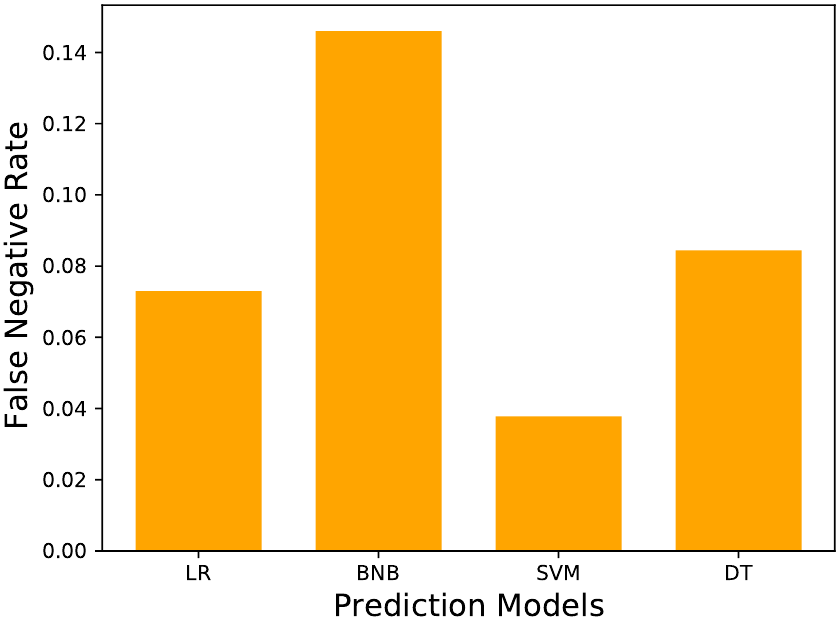
Figure 4. False negative rates (FNR) of the proposed ML algorithms for the potential COVID-19 carrier